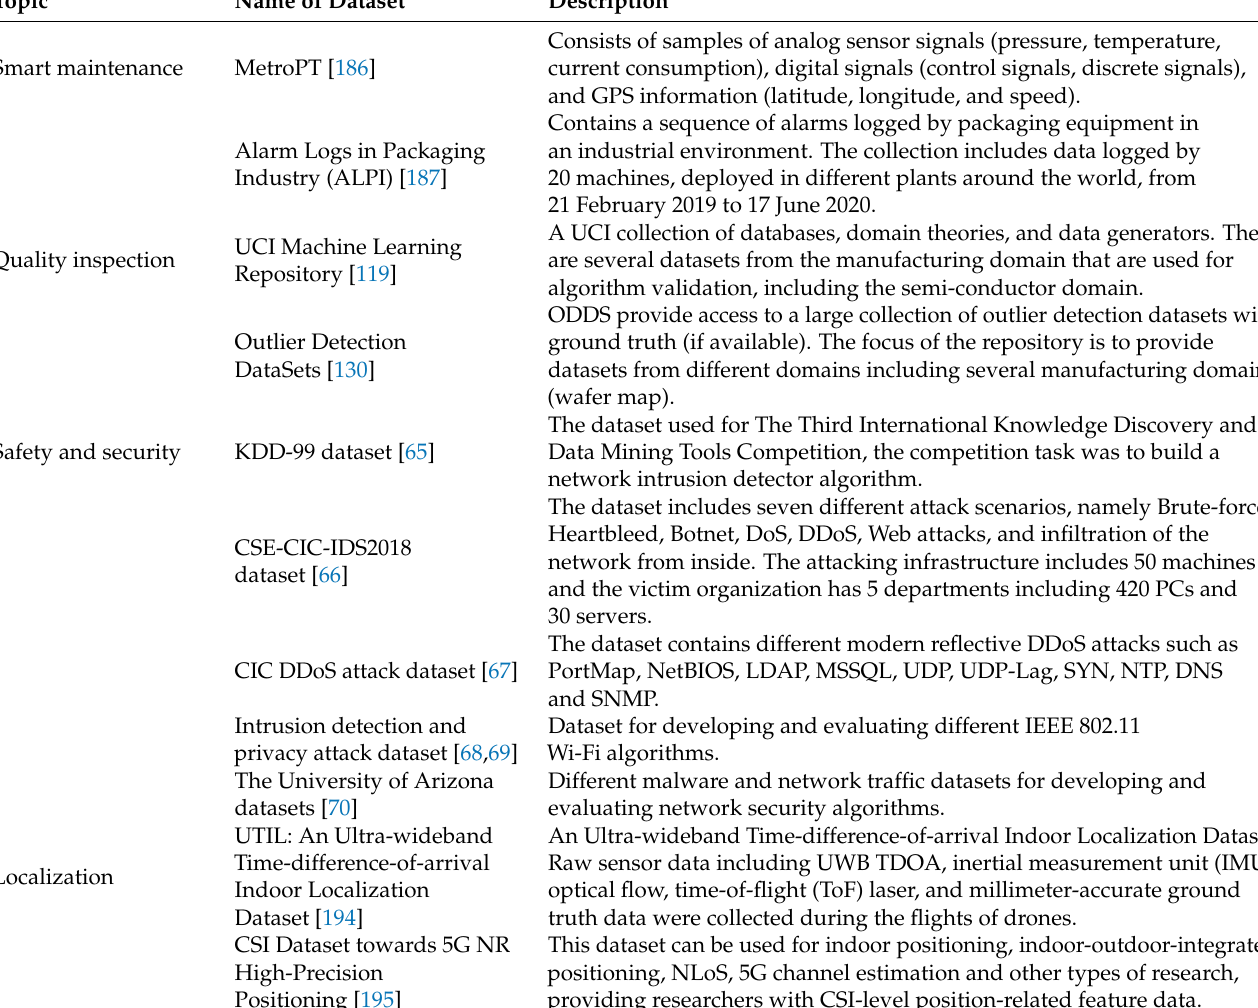
Table 5. Summary of major and typical datasets for IIoT machine learning